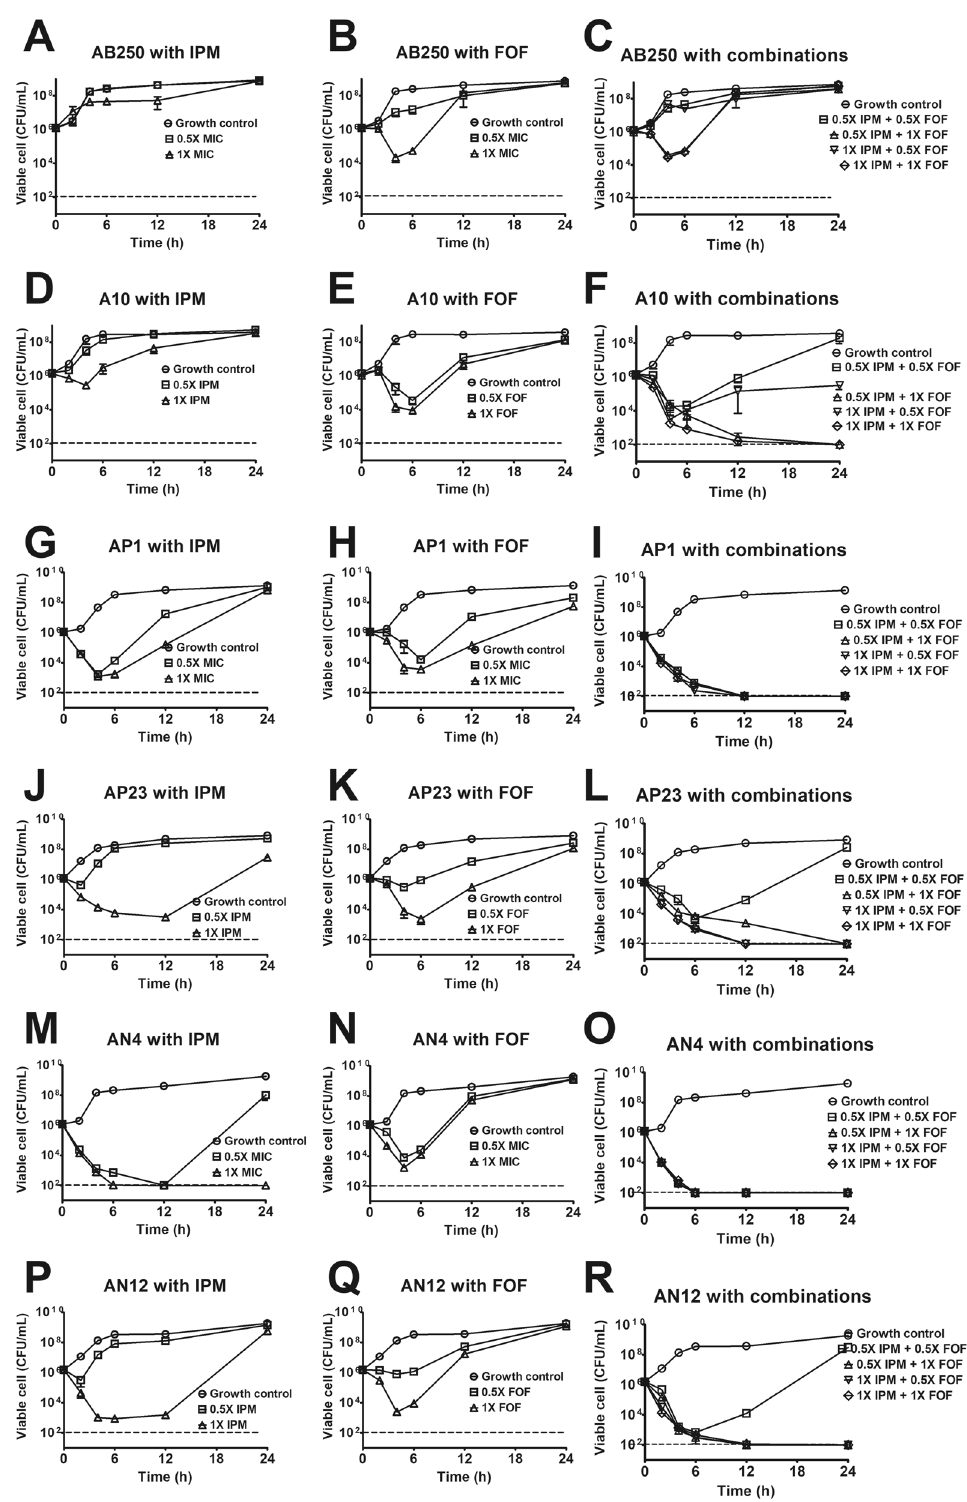
Figure 2. Time-killing curves of imipenem with fosfomycin against six ACB isolates. There were three conditions, including 0.5× MIC and 1× MIC of imipenem alone ( A , D , G , J , M , P ), 0.5× MIC and 1× MIC of fosfomycin alone ( B , E , H , K , N , Q ), and the combinations ( C , F , I , L , O , R ) Mean values of viable cells were plotted with error bars representing the standard error of the mean (n = 3). All experiments were performed in triplicate and the detection limit of the viable cells is 10 2 CFU/mL (dash